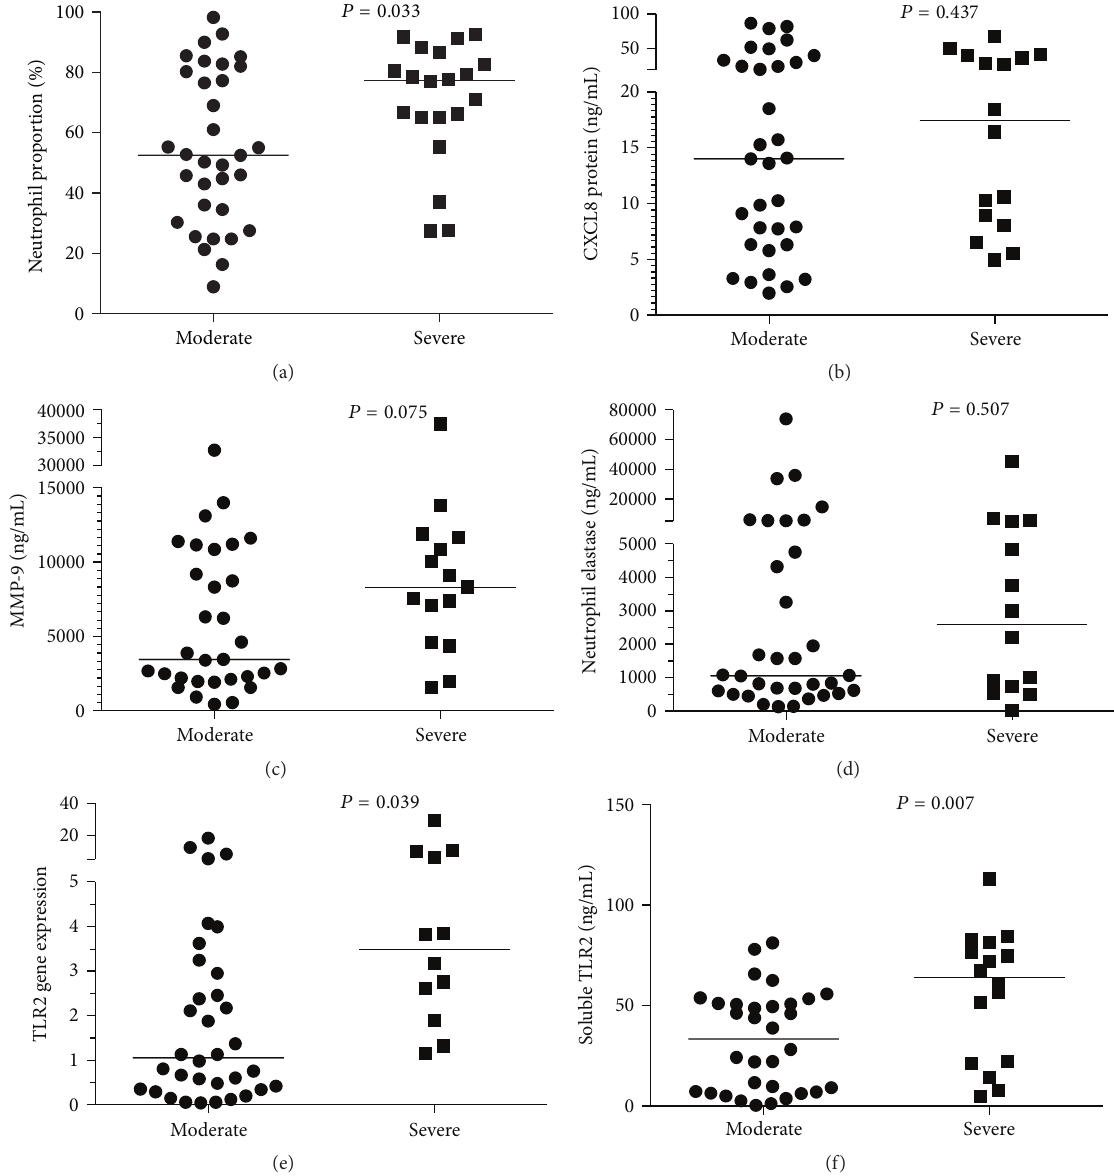
Figure 4: Analysis of the effect of the severity of airflow obstruction on markers of neutrophilic inflammation. This analysis compared participants with moderate and severe COPD. (a) Neutrophil number × 10 4 /mL, (b) CXCL8 protein ng/mL, (c) MMP-9 protein ng/mL, (d) NE protein ng/mL, (e) TLR2 gene expression, and (f) soluble TLR2